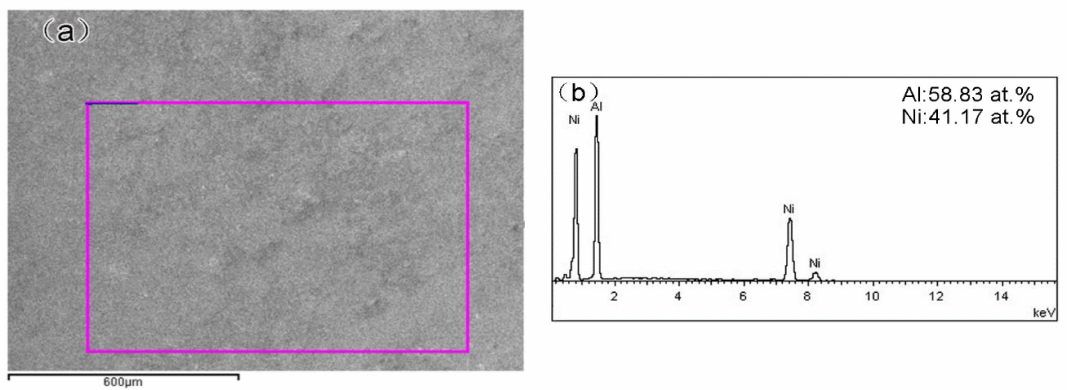
Figure 2. The morphology ( a ) and composition ( b ) of the Ni 2 Al 3 coating surface.